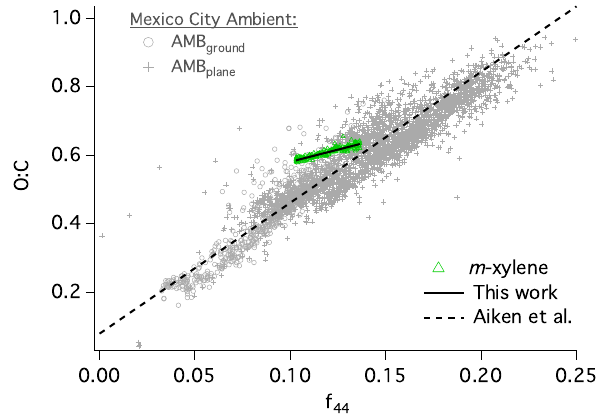
Fig. 4. Correlation of O:C with f 44 for SOA from m -xylene in the present study and Mexico City ambient aerosol from Aiken et al.